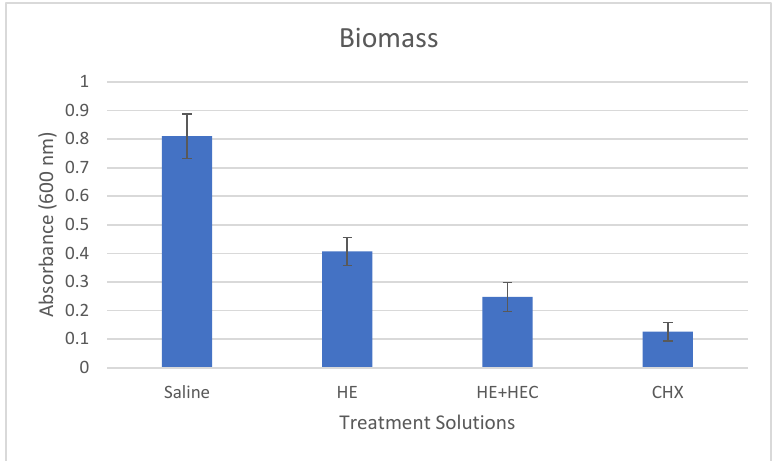
Figure 1. Effect of the various treatment solutions on Streptococcus mutans biofilm formation: saline as negative control; herbal extracts (HE); combined herbal extracts and hydroxyethyl cellulose (HE + HEC); and chlorhexidine (CHX) as positive control. Results (±standard deviation) are presented as absorbance at 600 nm.